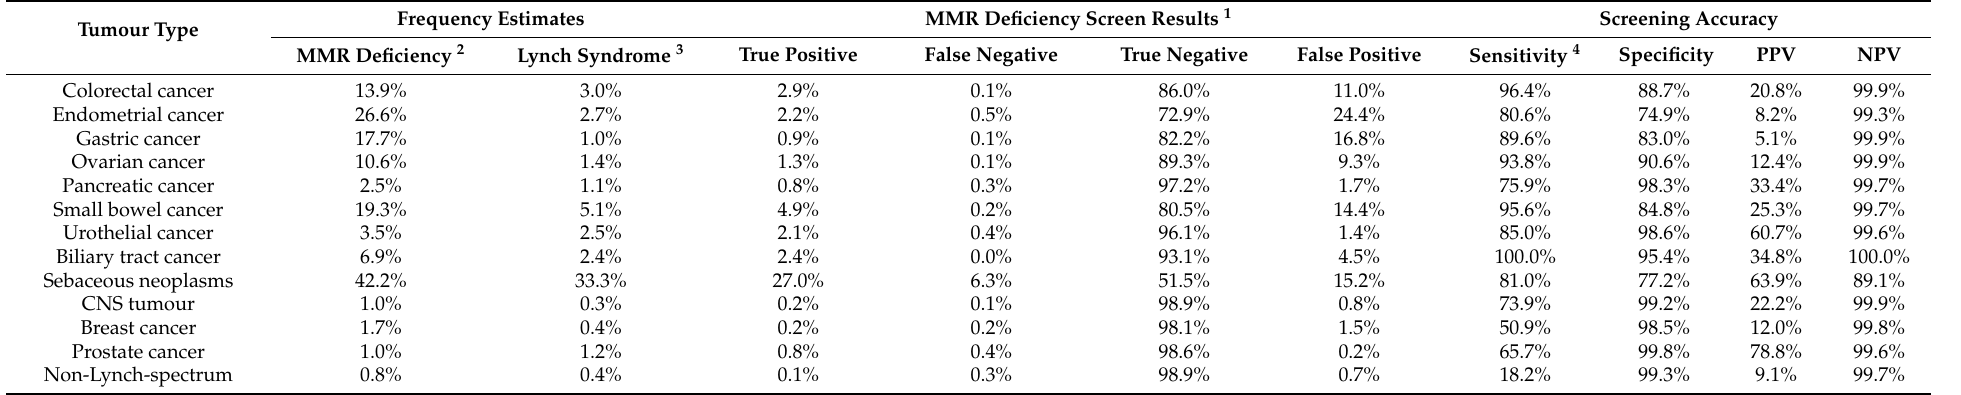
Table 4. Extrapolated accuracy statistics of mismatch repair (MMR) deficiency testing of different tumour types to screen for Lynch